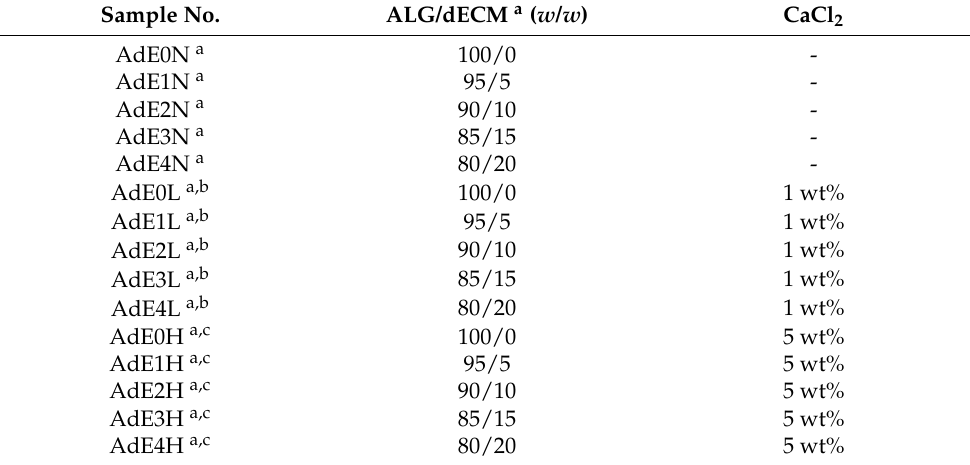
Table 1. Preparation of new ALG/dECM composite scaffold